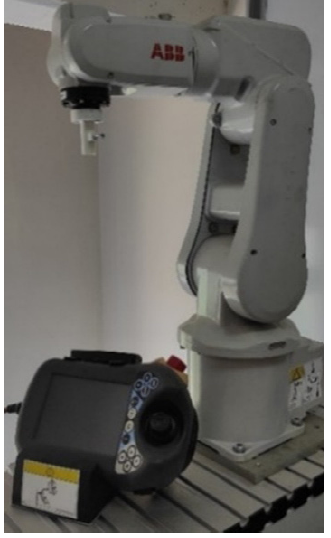
Figure 6. 6-degree of freedom industrial robot arm.